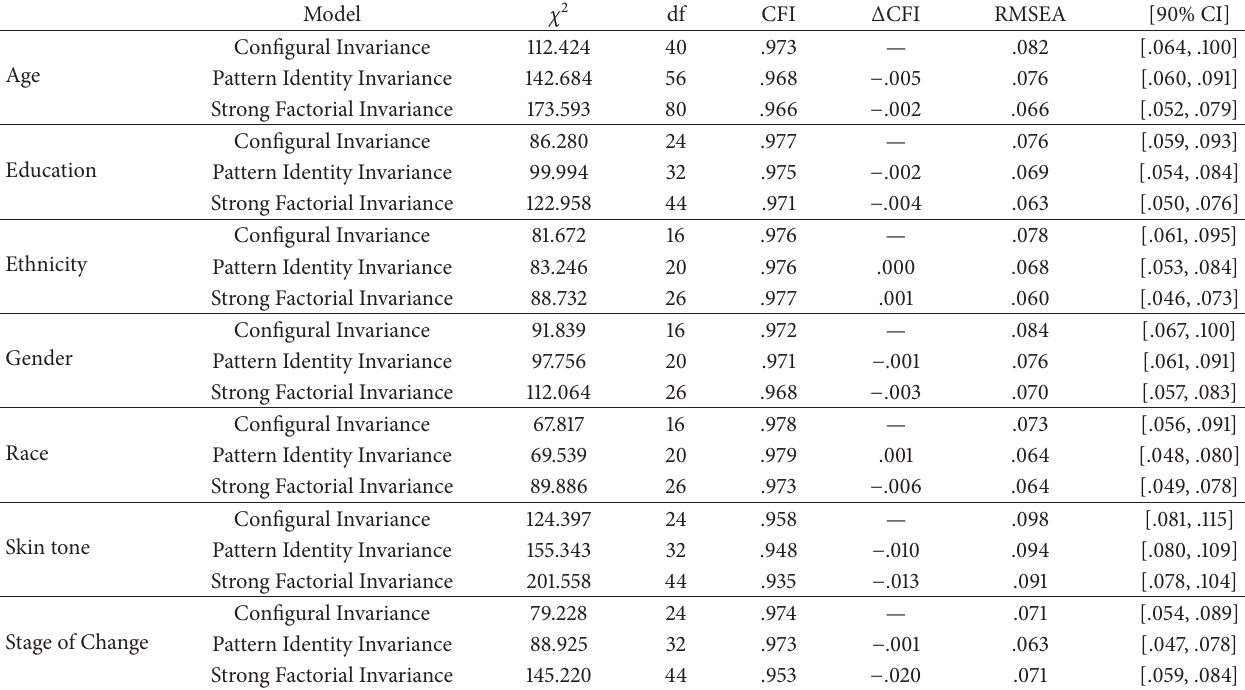
Table 2: Goodness-of-fit statistics for three invariance